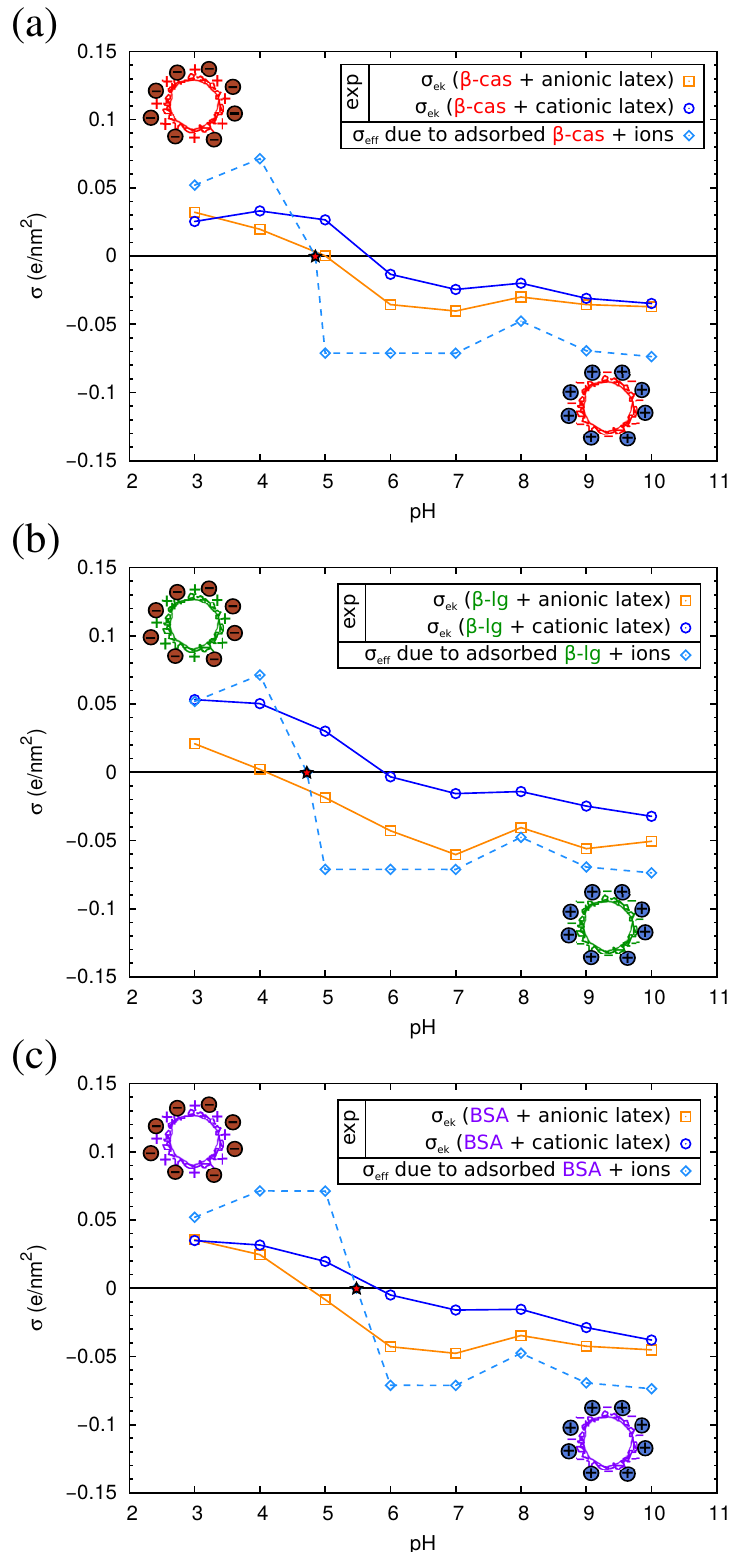
Figure 10. Electrokinetic charge ( σ ek ), obtained by Ohshima’s equation (Equation (5)), for the complexes consisting of proteins + anionic or cationic latex and effective charge ( σ ef f ) due to adsorbed protein taking into account ion condensation (Bocquet et al. model) for ( a ) β -casein; ( b ) β -lactoglobulin and ( c ) BSA. The star indicates the theoretical pI of the proteins from Propka calculations. The solid and dashed lines are used for guiding the